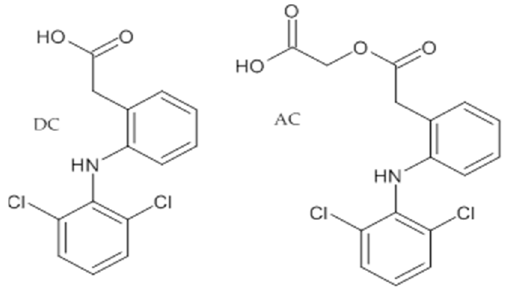
Figure 1. Structure of dicklofenac (DC) and aceclofenac (AC).